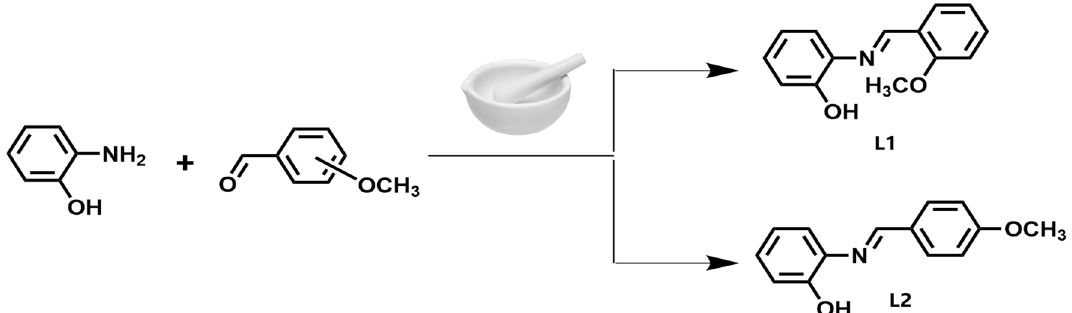
Figure 1. Synthetic procedure for Schiff base